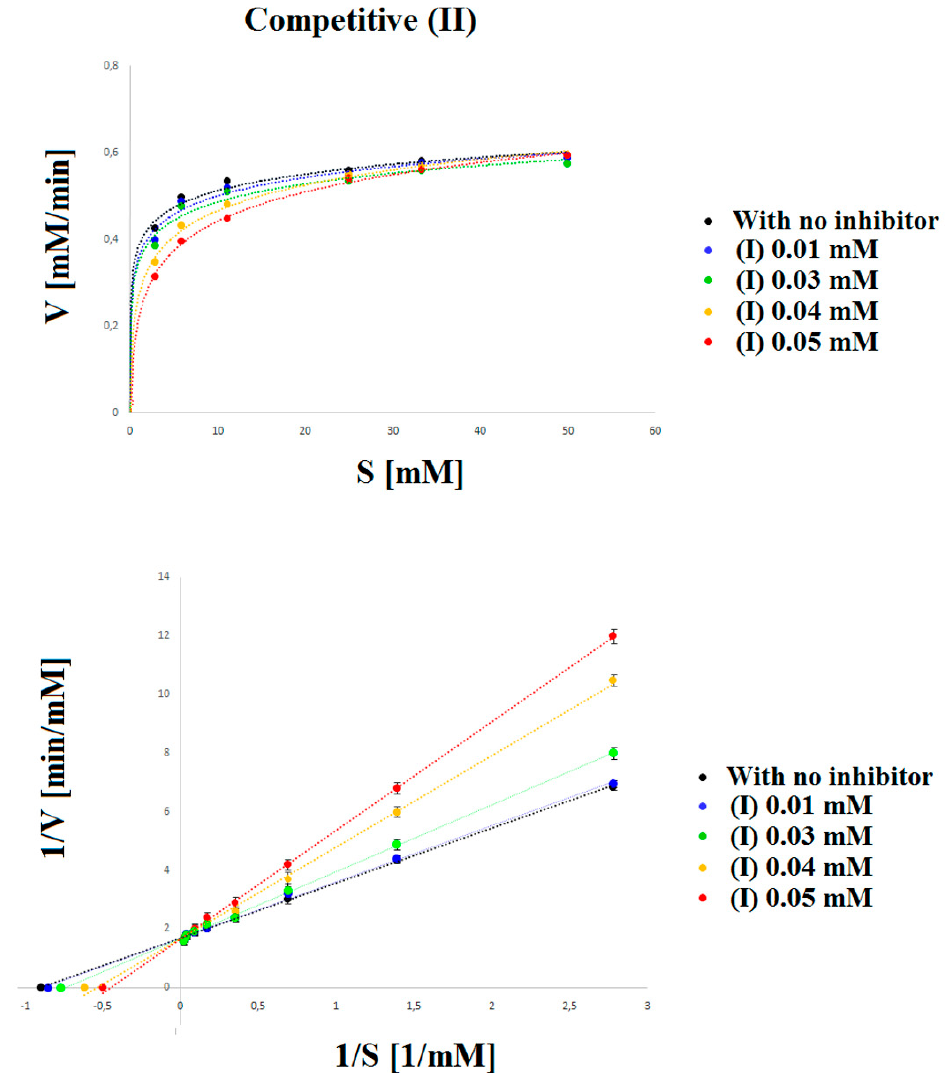
Figure 4. Michaelis–Menten and Lineweaver–Burk plots for the reaction of acid phosphatase with p-nitrophenyl phos- phate inhibited by: (•) 0.00 mM, (•) 0.01 mM, (•) 0.03 mM, (•) 0.04 mM and (•) 0.05 mM (II). The figure shows three straight lines with different intersection points with the 1/V axis and a common intersection with the 1/S axis. Such a system indicates the competitive type of inhibition. The larger the slope of the curve, the stronger the competitive inhib- itor of the tested compound